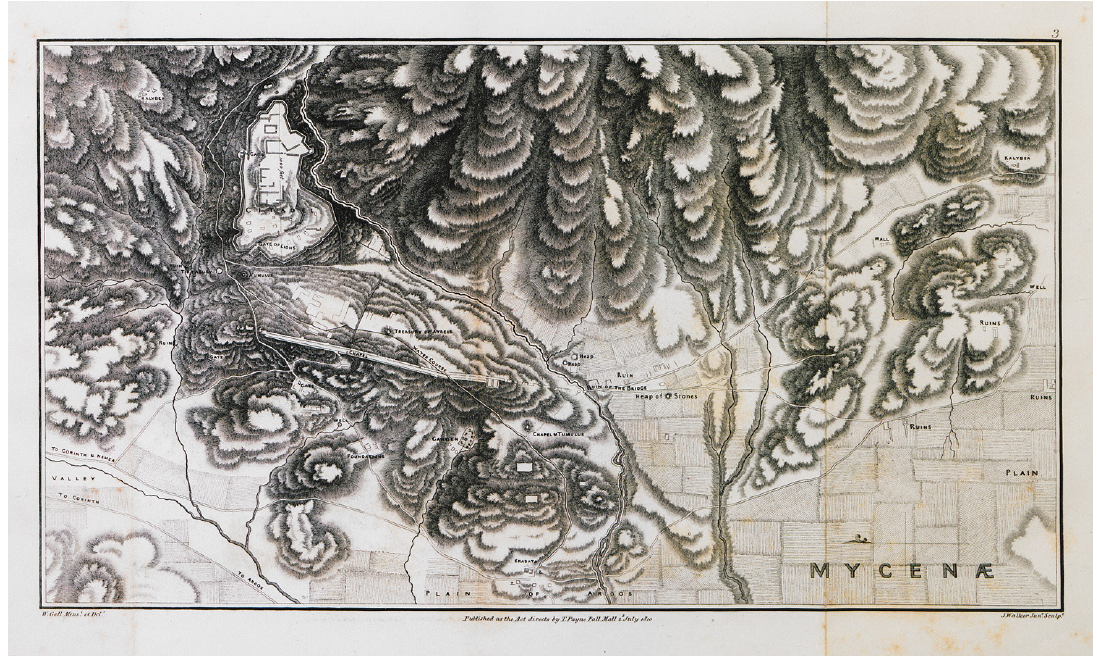
Figure 7. Map of the area of Mycenae (after Gell 1810, URL